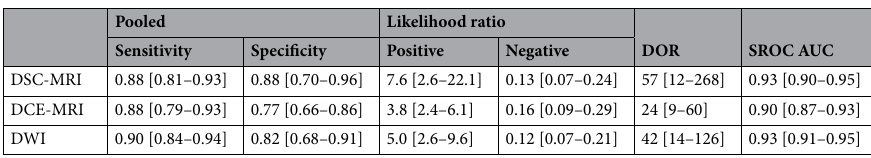
Table 2. Summary statistics comparing DSC-MRI, DCE-MRI, and DWI. DOR = diagnostic odds ratio; LR = likelihood ratio; SROC AUC = Summary receiver operator characteristics area under curve.